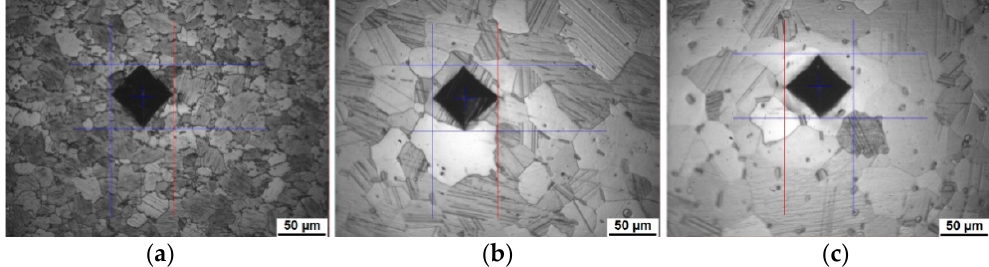
Figure 7. Optical micrographs of Mg ‐ Dy ‐ Nd ‐ Zn ‐ Zr alloy with HV0.2 indents in the: as ‐ extruded condition ( a ) and solution heat ‐ treated condition at 500 °C for 48 h( b , c ), grain with matrix LPSO lamellae ( b ) and grain without matrix LPSO lamellae ( c ).